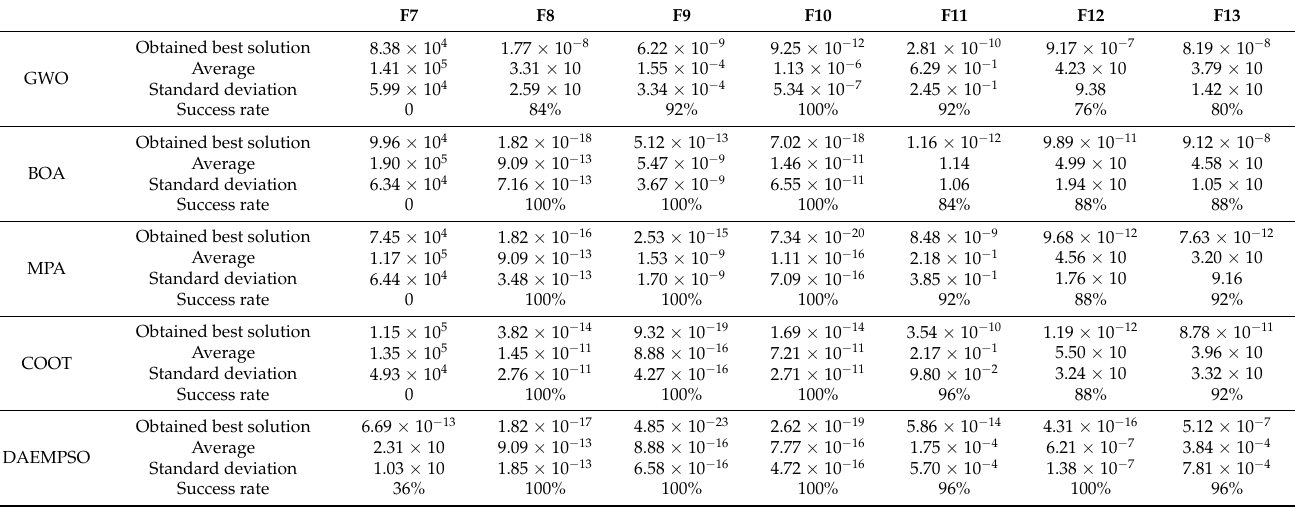
Table 4. Comparison of the optimization results of five algorithms for seven test functions (500